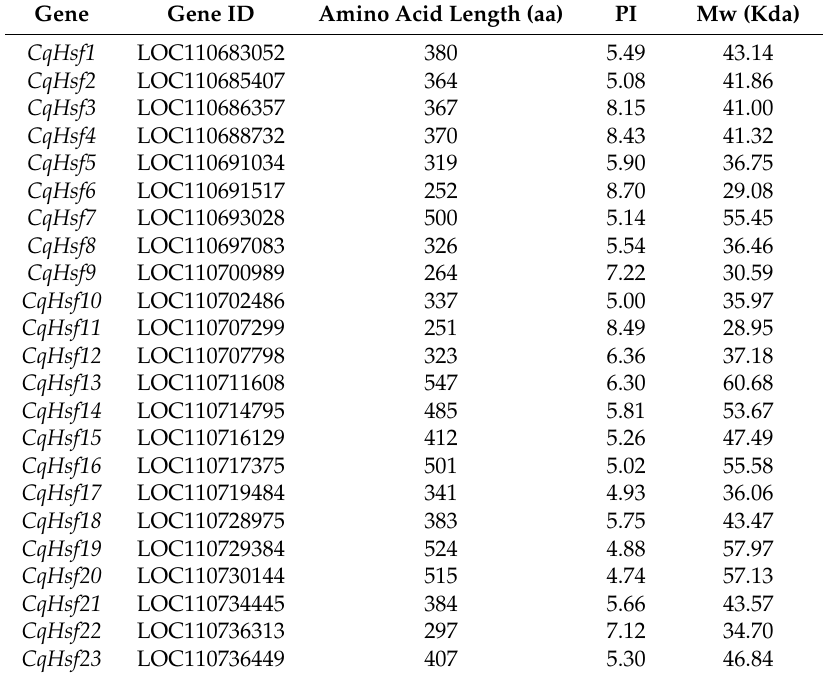
Table 1. Characteristics of heat shock transcription factors (Hsfs) in quinoa ( Chenopodium quinoa Willd.). Gene Gene